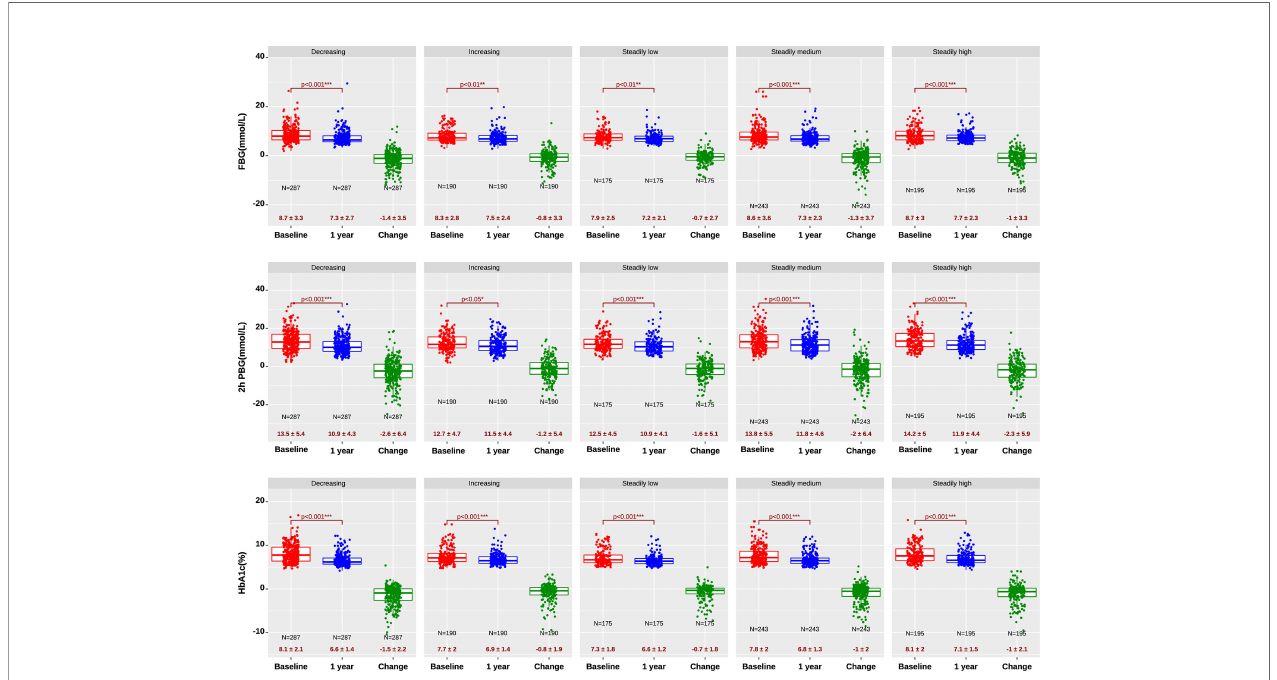
FIGURE 1 | FBG (top), 2h PBG (mid), and HbA1c (bottom) at baseline and after one-year treatment. Decreasing and steadily low salt intake leads to lower baseline FBG, 2h PBG, and HbA1c, as well as a larger decrease in FBG, 2h PBG, and HbA1c after treatment. *, signi fi cant with p<0.05; **, signi fi cant with p<0.01; ***, signi fi cant with